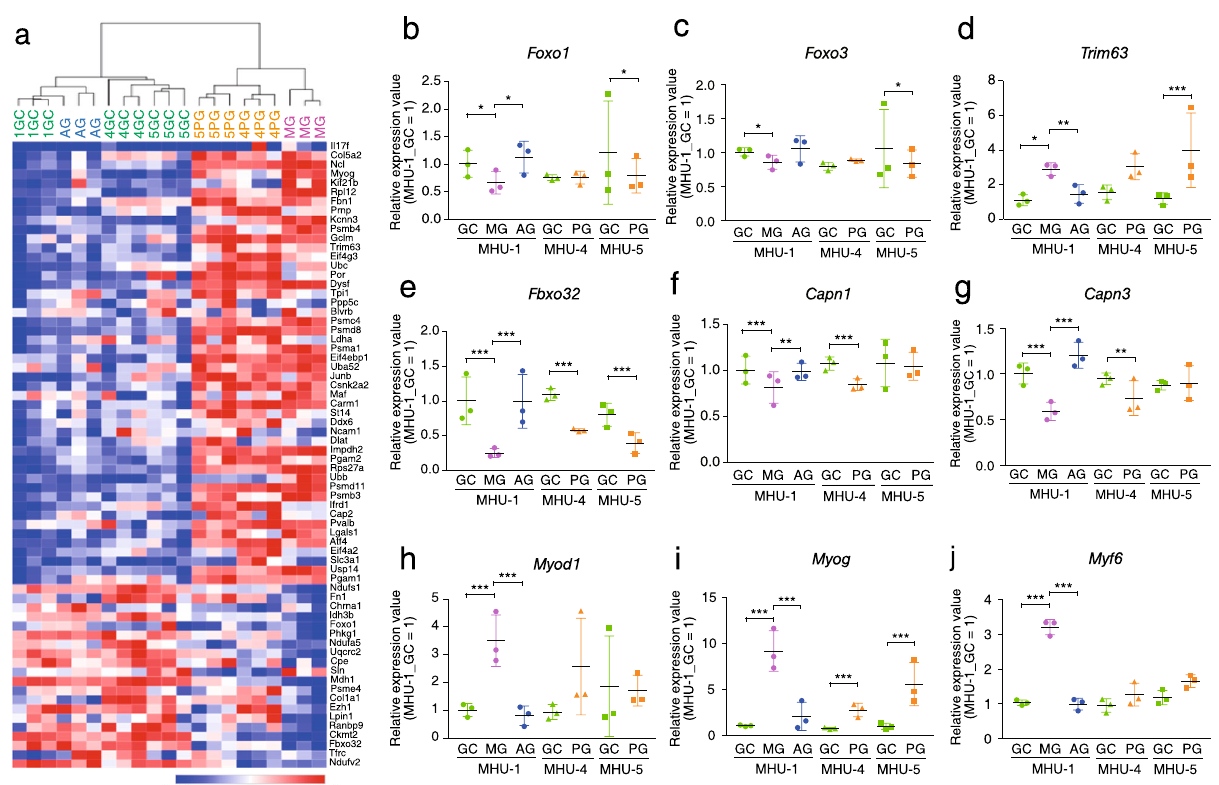
Fig. 4 Analysis of genes related to skeletal muscle plasticity under conditions of microgravity and lunar gravity. a Heatmap of atrogene expression values in the soleus muscles from mouse habitat unit (MHU)-1, -4, and -5_GC, MHU-1_MG, MHU-1_AG, MHU-4_PG, and MHU-5_PG mice. 1GC: MHU- 1_GC; 4GC: MHU-4_GC; 5GC: MHU-5_GC; MG: MHU-1_MG; AG: MHU-1_AG; 4PG: MHU-4_PG; 5PG: MHU-5_PG. b – j Gene expression of Foxo1 , Foxo3 , Trim63 , Fbxo32 , Capn1 , Capn3 , Myod1 , Myog , and Myf6 in the soleus muscle. Data are represented as the mean and SD, and each point represents an individual mouse ( n = 3). Expression values are normalized by transcripts per million (each MHU-1_GC = 1). P values were calculated using the edgeR test; * P < 0.05, ** P < 0.01, and *** P < 0.001 for all groups in panels b – j (false discovery